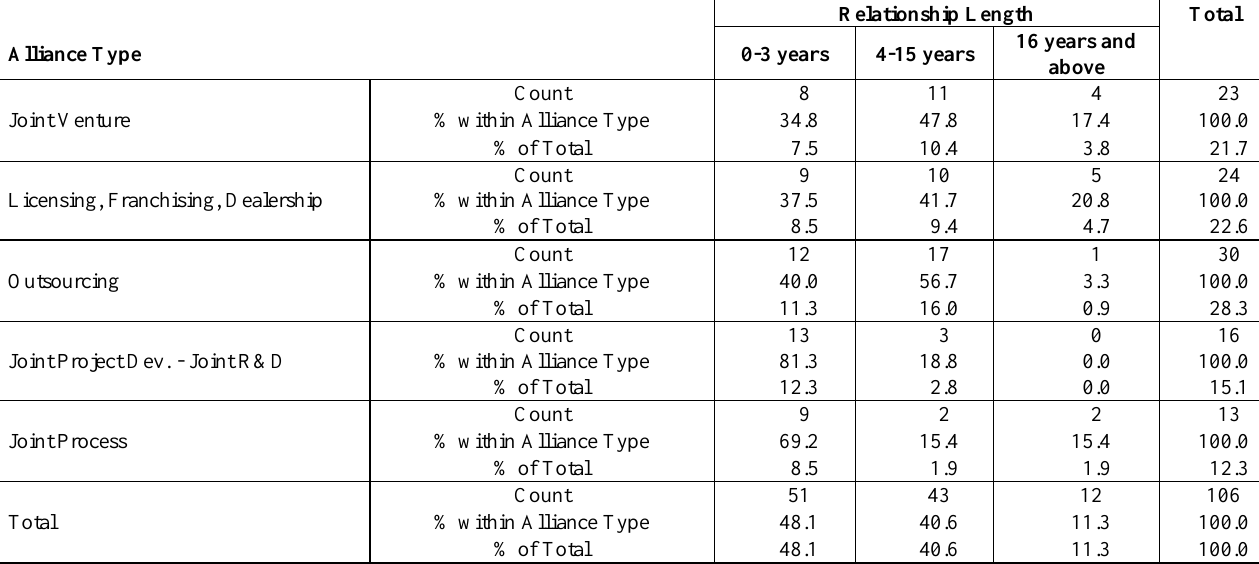
Relationship Length Total